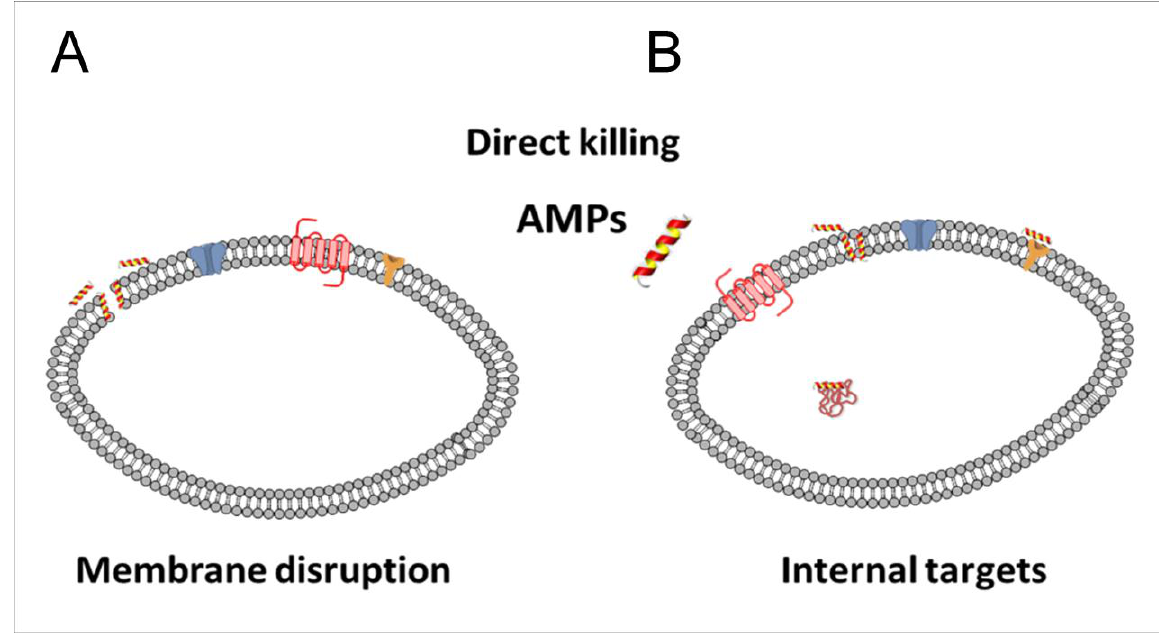
Figure 7. Direct killing mechanisms of antimicrobial peptides. The peptides are typically classified as membrane disrupting ( A ) or as molecules that act through more specific extra- or intracellular targets ( B